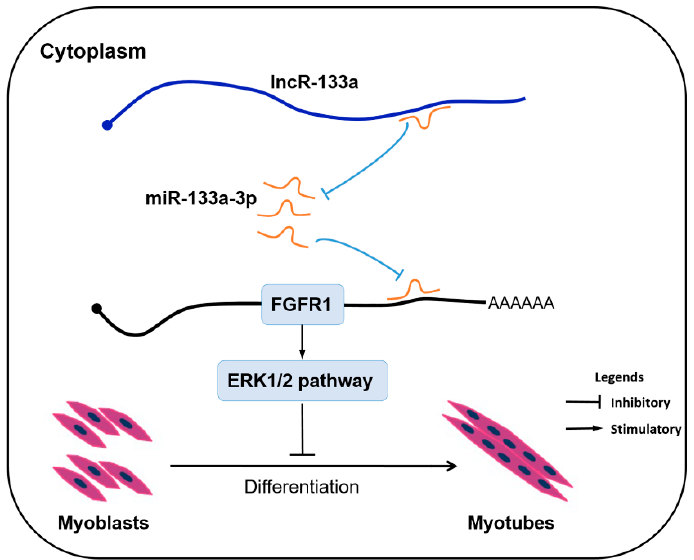
Figure 7. A proposed model of lncR-133a-mediated regulation of myogenic differentiation. LncR-133a activates FGFR1/ERK1/2 signaling and suppresses muscle differentiation by sponging miR-133a-3p. Supplementary Materials: The following supporting information can be downloaded at: https: lncR-133a; Figure S2: Expression pattern of myogenesis marker genes (Pax7, MyoD, MyoG, and MyHC). ( a ) qRT-PCR measured the expression levels of four marker genes in goat different tissues on day 60 of gestation. ( b ) The expression levels of four marker genes in the developmental LTL